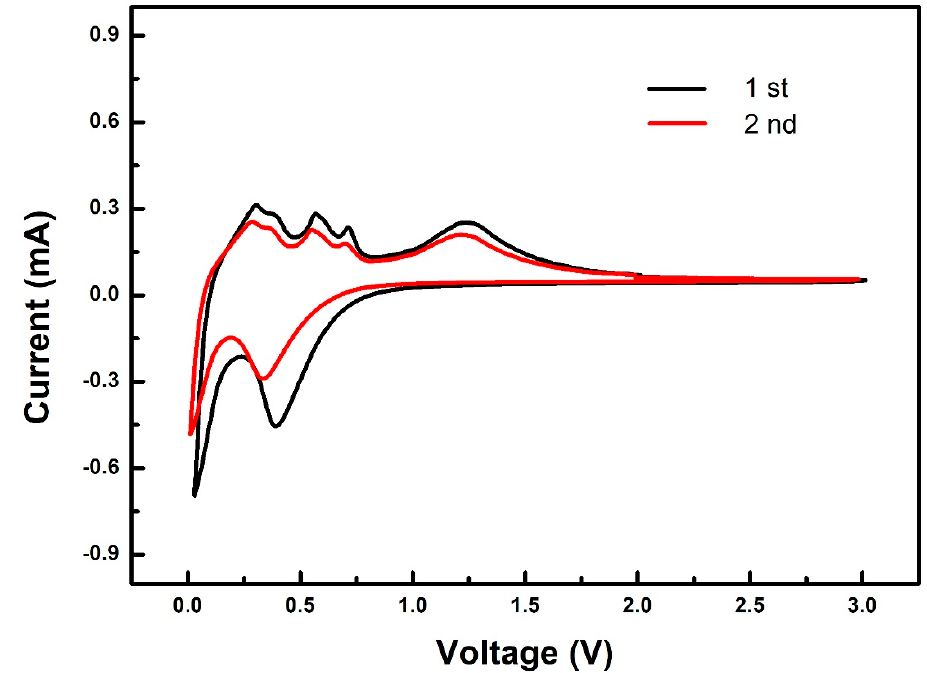
Figure 9. Cyclic voltammogram (CV) curves of the ZnO/graphene composite electrode at a scan rate of 0.1 mV s − 1 .